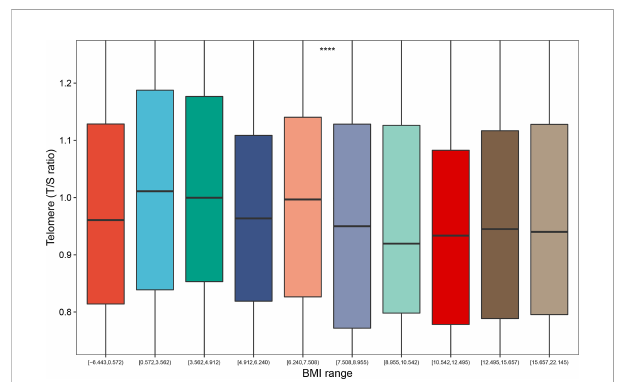
FIGURE 1 Distribution of telomere length according to the BMI range